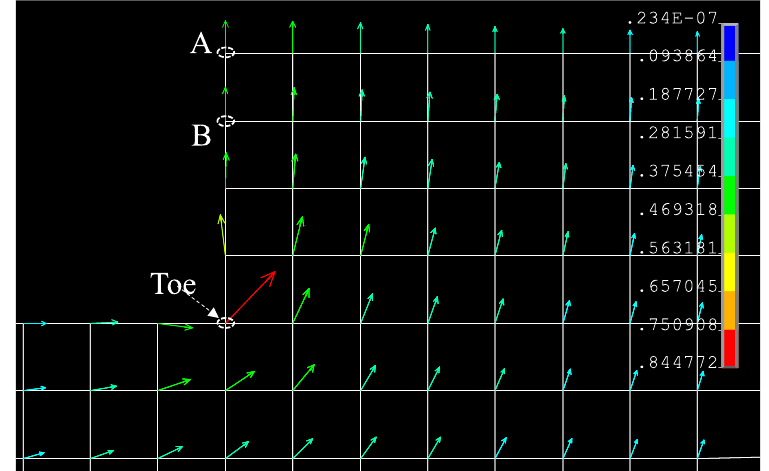
Fig. 5 . Vector plot of hydraulic gradient using 8-noded element of size ℎ = 0.5 𝑚